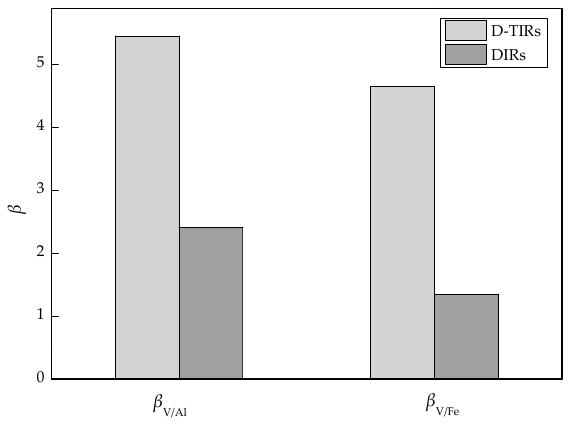
Figure 11. Separation factor of V(IV) over Al(III), and V(IV) over Fe(II) onto resins.